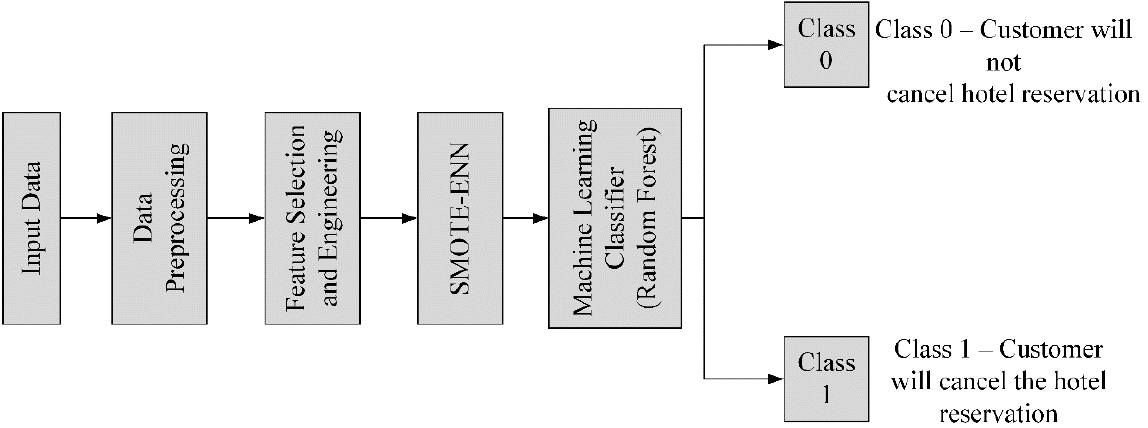
Figure 1. Representation of the conceptual methodology.